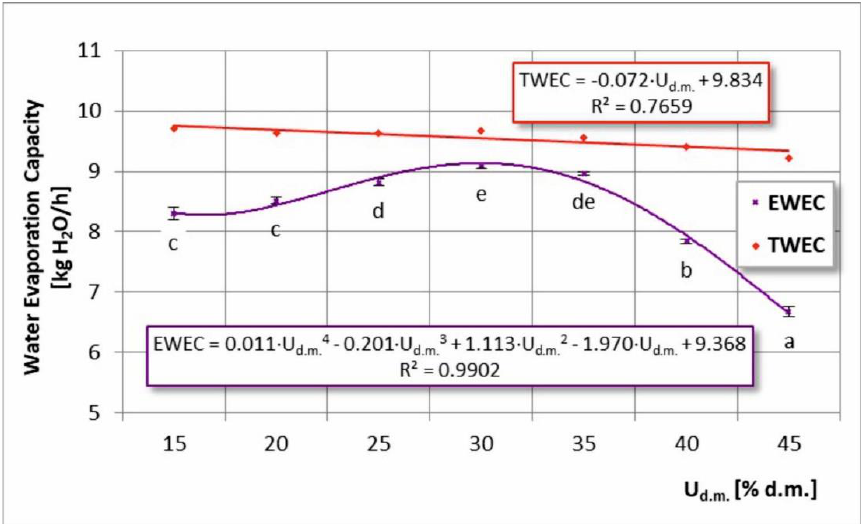
Figure 6. Total (TWEC) and effective water evaporation capacity (EWEC) in the process of spray drying chokeberry juice with different dry matter content in the feed solution (U d.m. ); (a, b, c, d, e — different letters show significant differences between mean values ( p ≤ 0.05)).